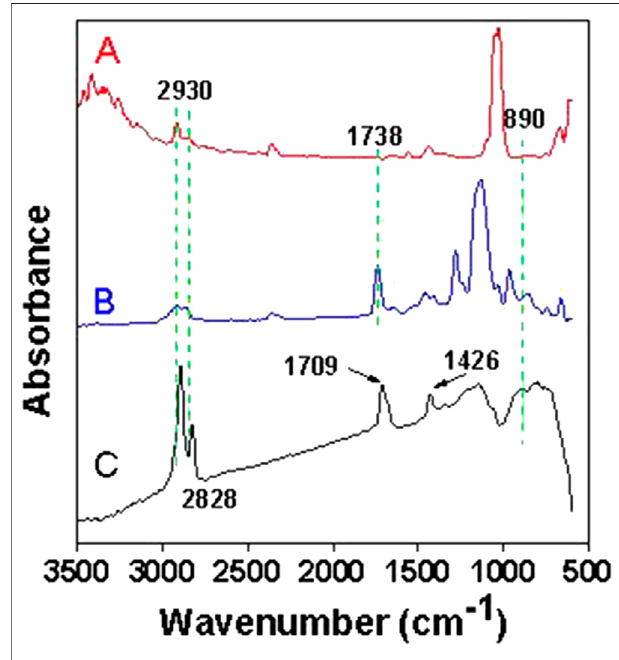
FIGURE 3 | ATR-FTIR spectra of (A) DP, (B) SA-DP, and (C)